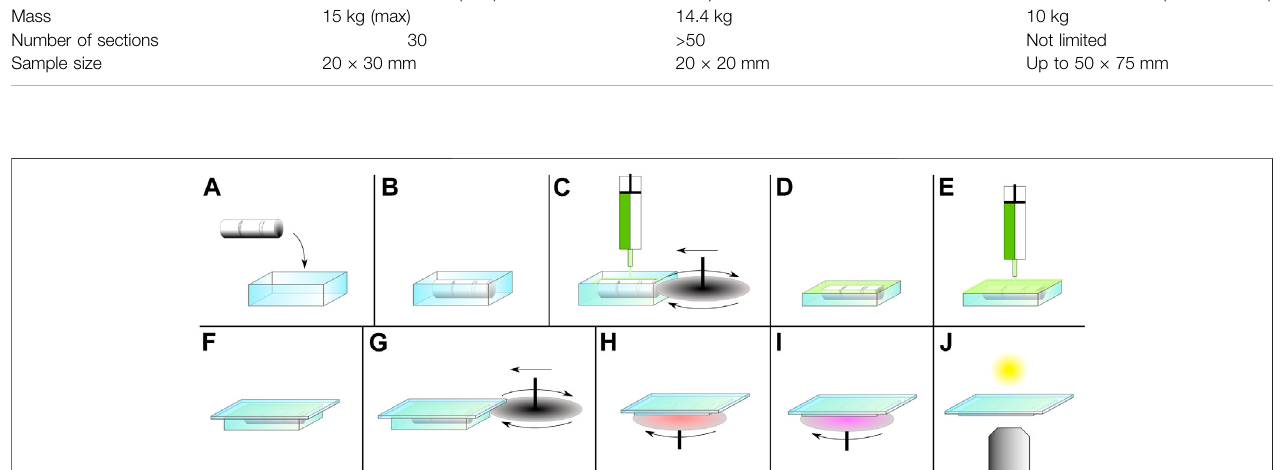
FIGURE 2 | Schematic protocol for automated thin section preparation. (A – C) A drill core is placed into a container and indurated. (C,D) The whole is cut in the middlealongthecoreaxis. (E,F) Alayerofresinisdepositedandaglassslideisgluedonthetopoftheremainingsample. (G) Thesampleiscutclosetotheglassslidein order to keep a ∼ 100 µm thick slice of rock. (H,I) The rock surface is ground and polished. (J) The 30 µm rock thin section is analysed from the bottom with an inverted microscope.